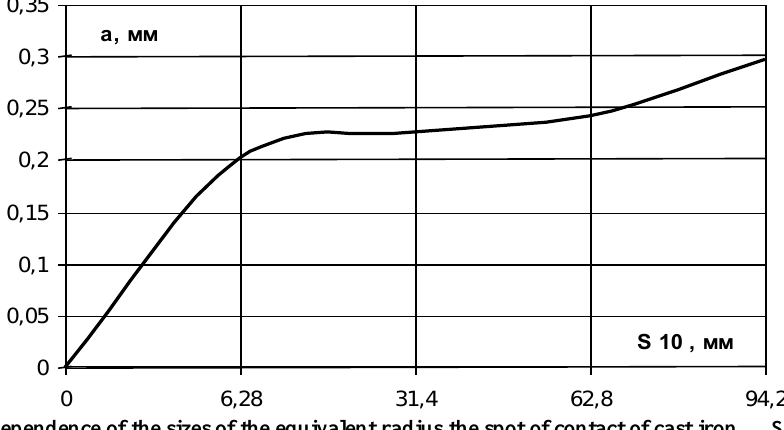
Fig. 3. Graph of the dependence of the sizes of the equivalent radius the spot of contact of cast iron SC 20 from the friction path In Fig. 4 combined Fig. 2 and 3.